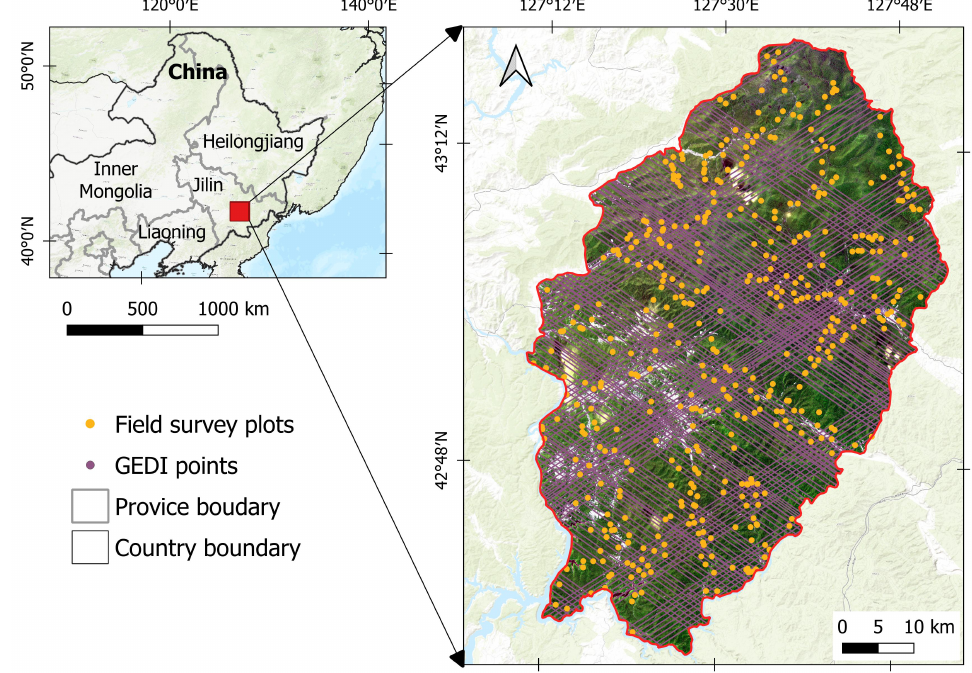
Figure 1. Location of the study area. The yellow dots on Sentinel-2 imagery are the sampling plots, while purple dots indicate the GEDI footprints used in this study.